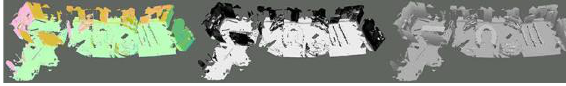
Figure 1: From left to right: Geometry focused visualization